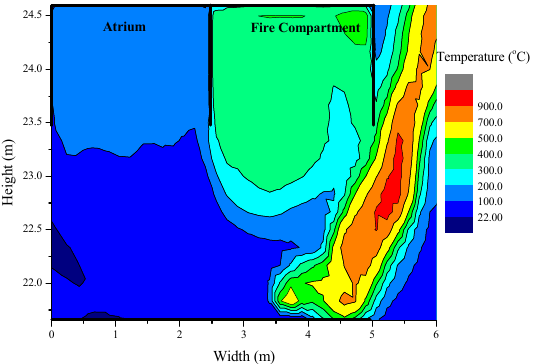
Figure 10. Temperature distributions in the atrium and fire compartment at 4 m/s and 120 s.